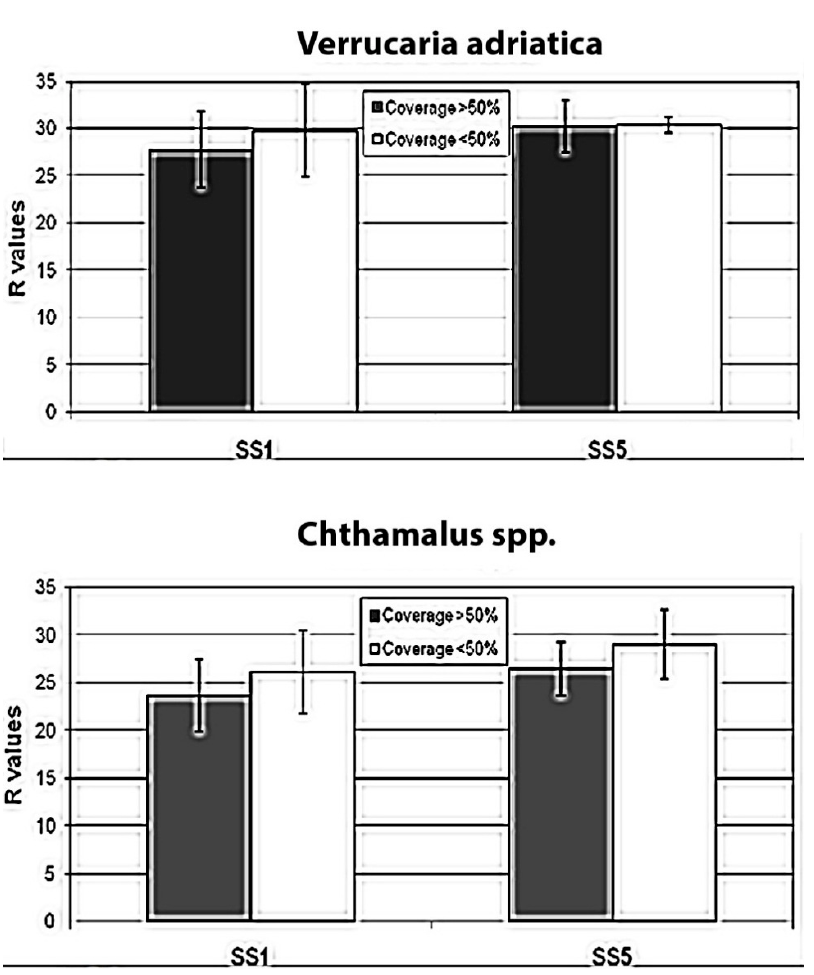
Figure 7. Mean R values at both sites, SS1 and SS5.